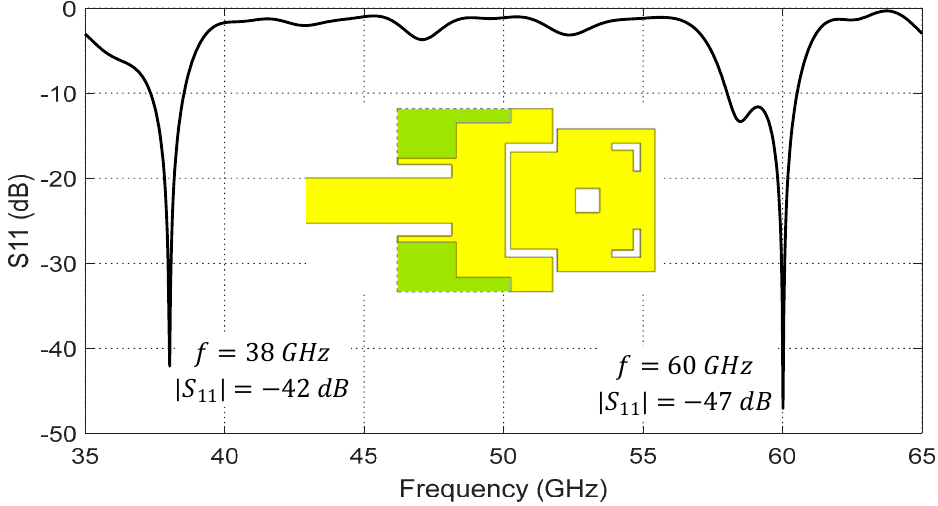
Figure 7. Simulated dependence of the return loss, | S 11 | , on the frequency over a wide band of the frequency for the proposed dual-patch antenna (final design).